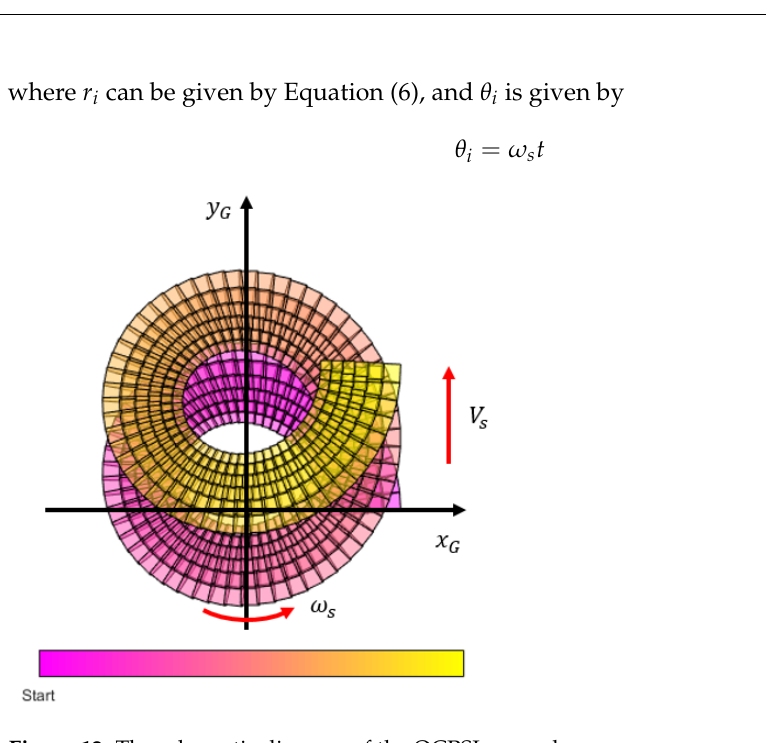
Figure 12. The schematic diagram of the OCPSI ground coverage.